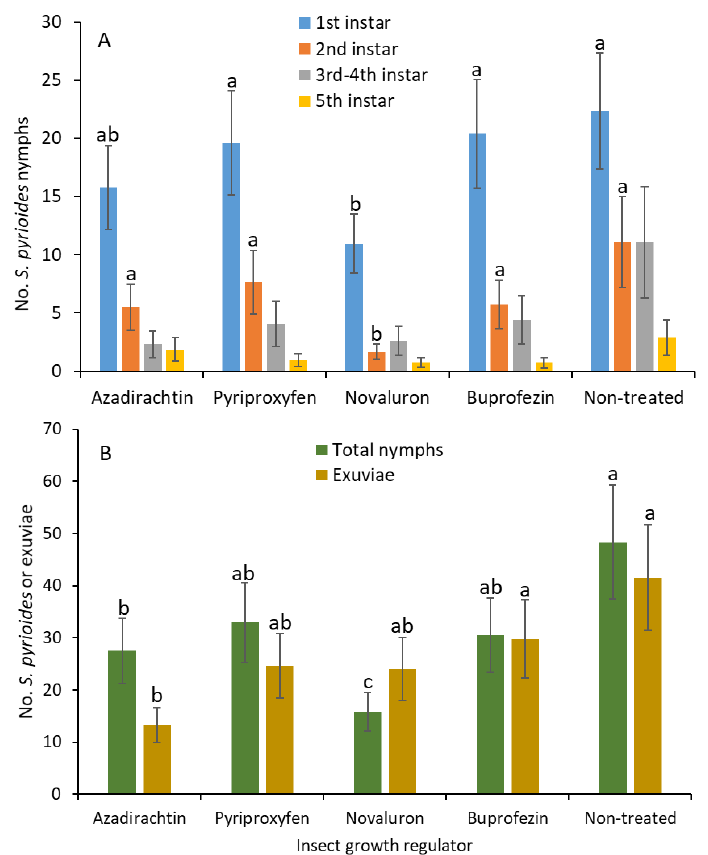
Figure 3. Least squares mean ( ± SE) numbers of various instars from S. pyrioides in ( A ) the first, second, third and fourth, and fifth instars and ( B ) the total nymphs and exuviae at 7 d posttreatment when IGRs with adjuvant were painted on the adaxial surfaces of leaves after S. pyrioides eggs were implanted. Bars of the same fill color with the same letters are not significantly different (pairwise t -test, p = 0.05). Nonsignificant data have no letters.